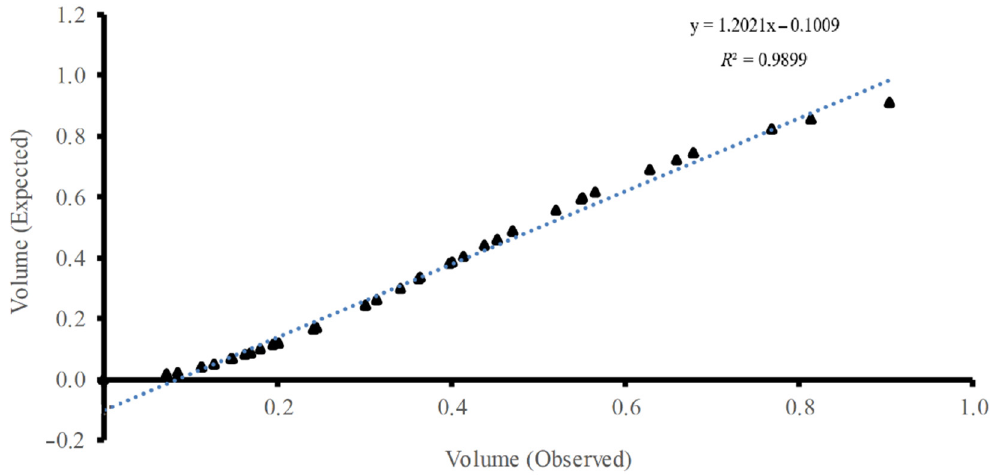
Figure 3. Observed vs. expected volume data.